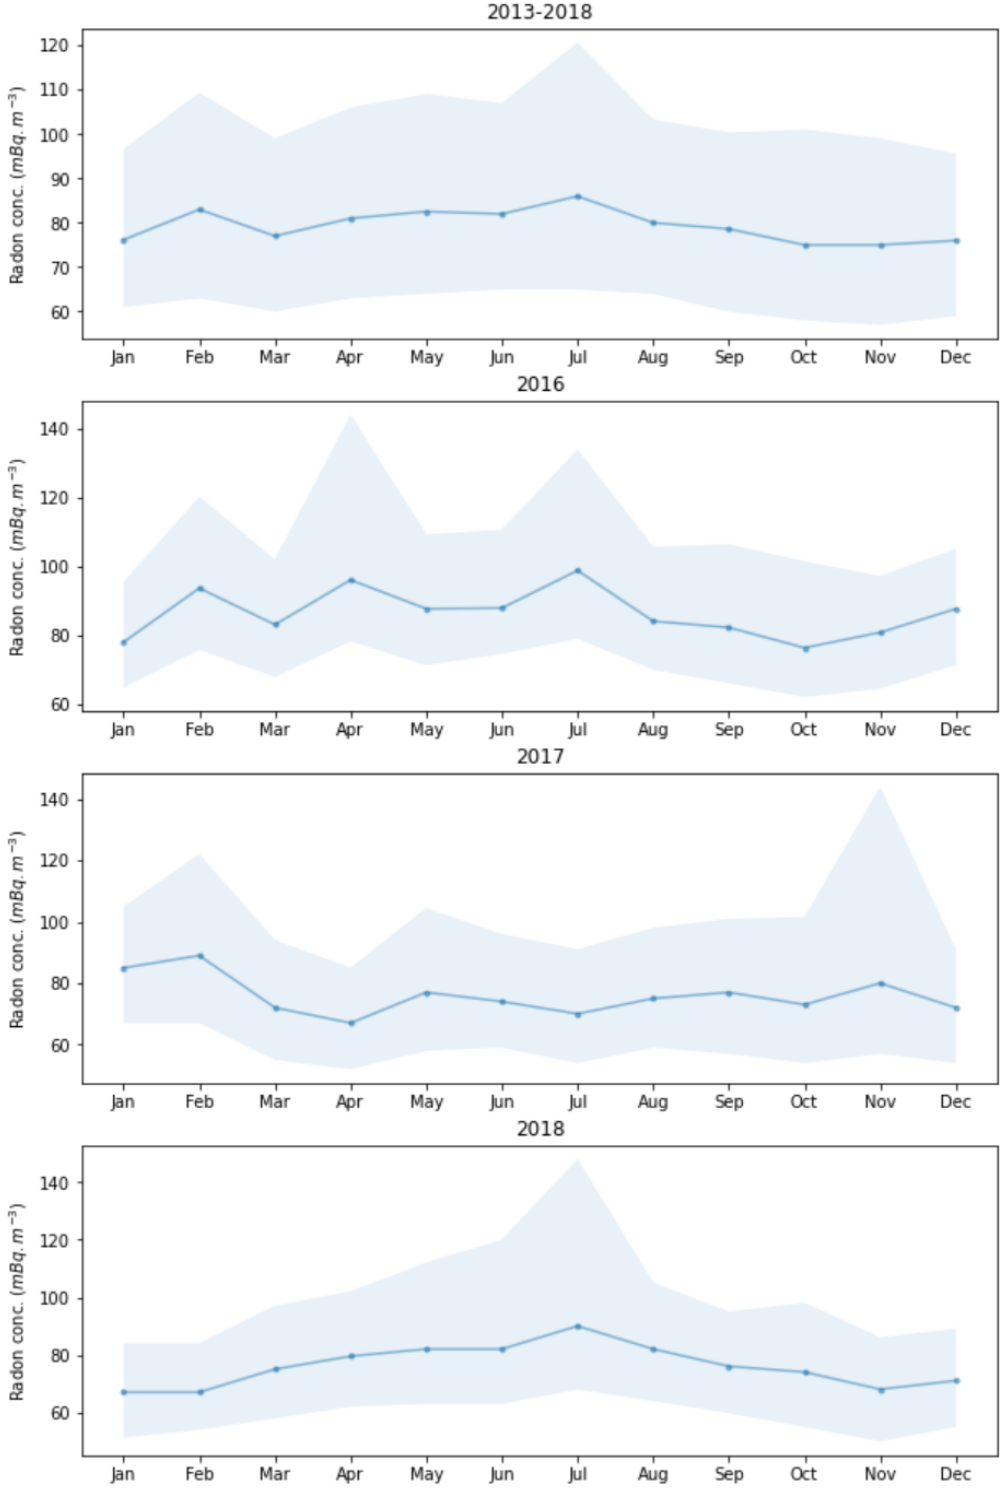
Figure A5. Annual cycles of radon for the 6 years of data available (top) and each separate year of the ACRE campaign. Note that 2016 is where the CCN anomaly is